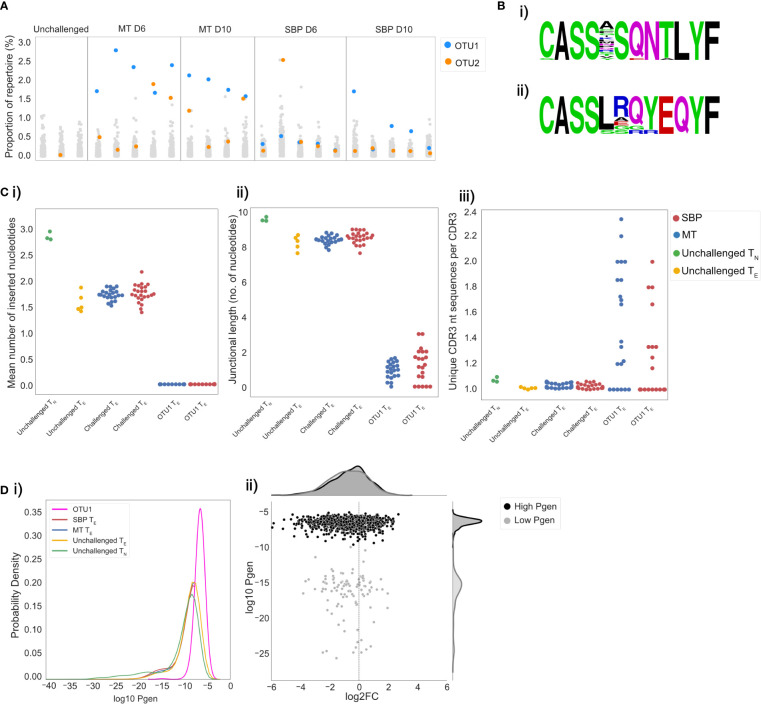
Acute mosquito-transmitted (MT) TE repertoires are dominated by the same cluster of clones. Repertoires were clustered using a modified Swarm algorithm, to cluster CDR3 sequences within 1 amino-acid mismatch of each other, with identical V-gene usage. (A) Strip plots display the proportion of repertoire occupied by each cluster in individual repertoires for unchallenged TN and MT and SBP TE repertoires at day 6 and 10 post-infection. Each column is an individual repertoire, with each point representing a unique cluster. Cluster OTU1 is displayed in blue and OTU2 in orange. (B) Representative amino acid sequence logos of clusters OTU1 and OTU2. (C) OTU1 CDR3 sequences have hallmarks of a public response: (i) mean number of inserted random nucleotides in CDR3 sequences, (ii) mean number of nucleotides lying between V and J gene segment sequences and (iii) convergence (mean number of unique nucleotide sequences that encode a particular CDR3 sequence), for unchallenged TN (green), unchallenged TE repertoires (yellow), all MT TE repertoires (blue) and all SBP TE repertoires (red) and for cluster OTU1 in all MT and SBP TE repertoires. (D) (i) Distributions of the generation probabilities (log10) of CDR3 nucleotide sequences for unchallenged TN (green) and TE repertoires (yellow), SBP (red) and MT (blue) TE repertoires and CDR3 nucleotide sequences of cluster OTU1 (pink). (ii) Log2 fold change of clones present in unchallenged TN repertoires versus challenged TE repertoires. Each point represents an individual clone, and Pgen is separated in to high (>−10) (black) and low (<-10) (gray). Log2FC was calculated on UMI normalized data.